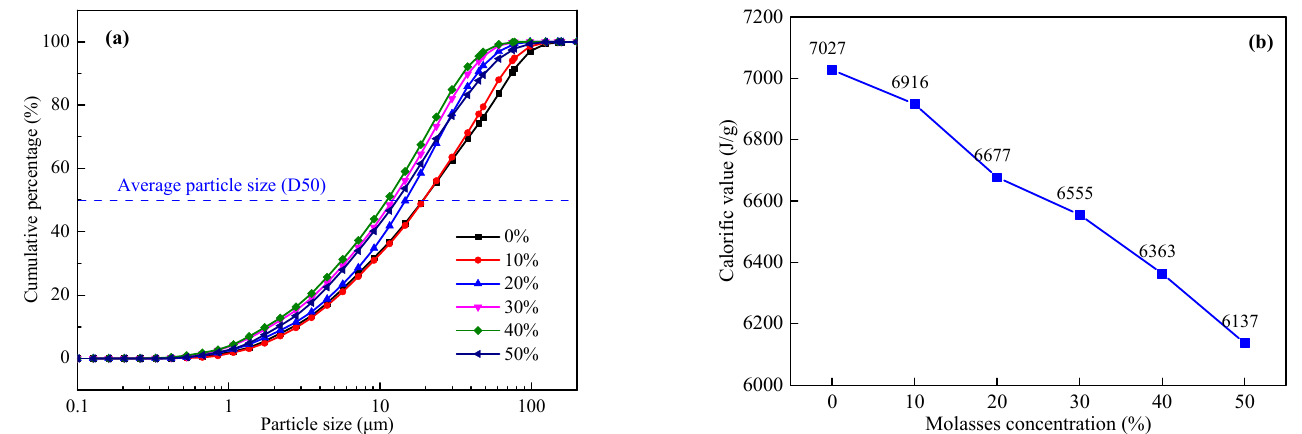
Figure 1. The particle size distributions ( a ) and the calorific values ( b ) of the explosion coal dust samples.